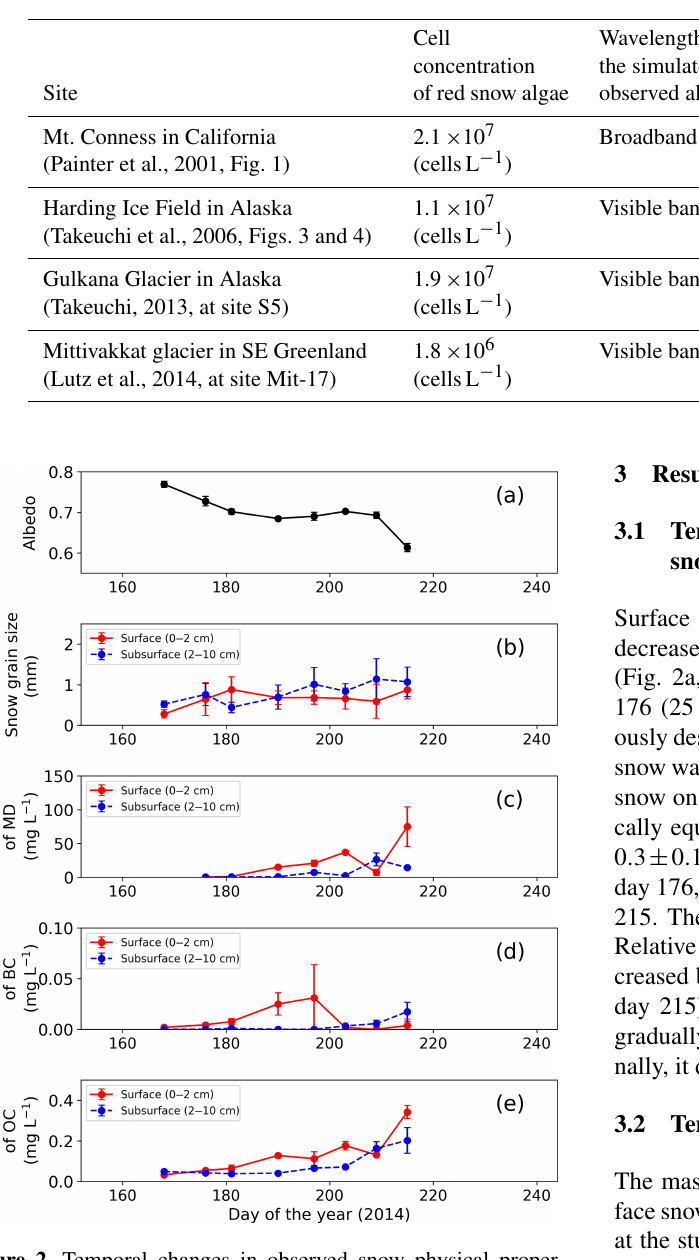
Figure 2. Temporal changes in observed snow physical proper- ties on surface and subsurface snow at the study site. (a) Snow albedo, (b) snow grain size (radius), (c) mass concentration of MD, (d) mass concentration of BC and (e) mass concentration of OC. Snow albedo was calculated from the ratio of upward and down- ward shortwave radiation at AWS. Error bars: standard